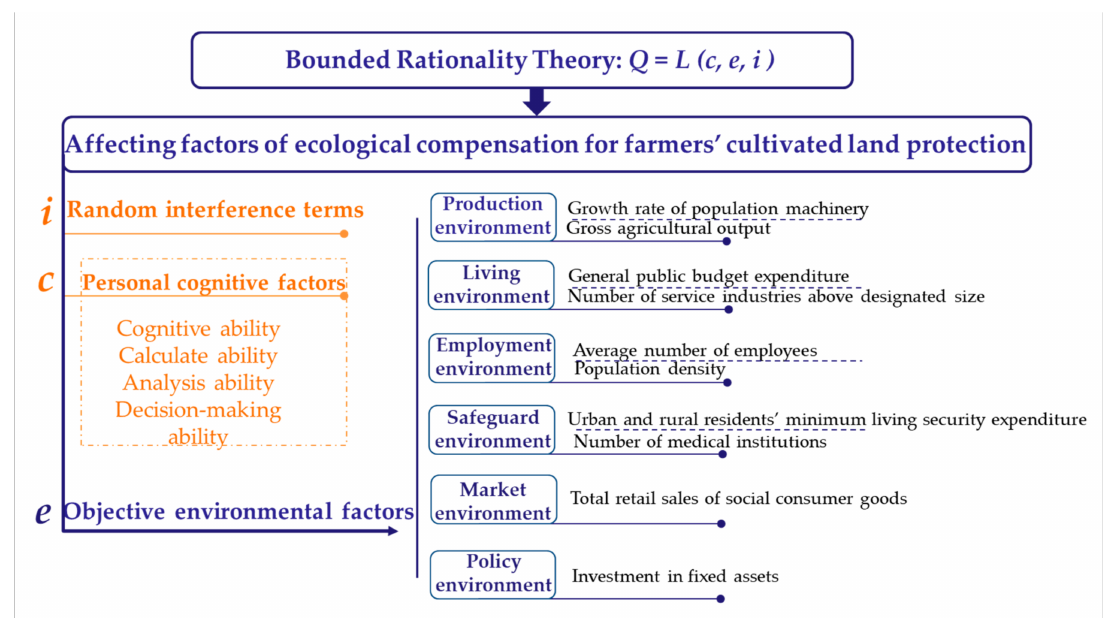
Figure 2. Factors a ff ecting ecological compensation for farmers’ cultivated land